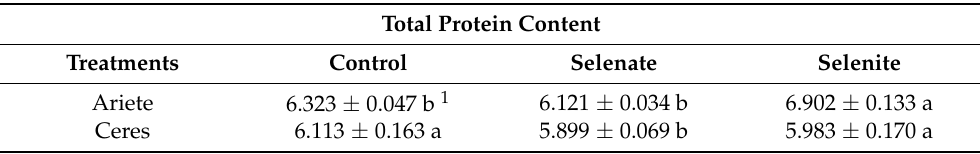
Table 2. Average (%) ± standard error ( n = 4) of protein content in whole rice flour submitted to foliar pulverization of sodium selenate and sodium